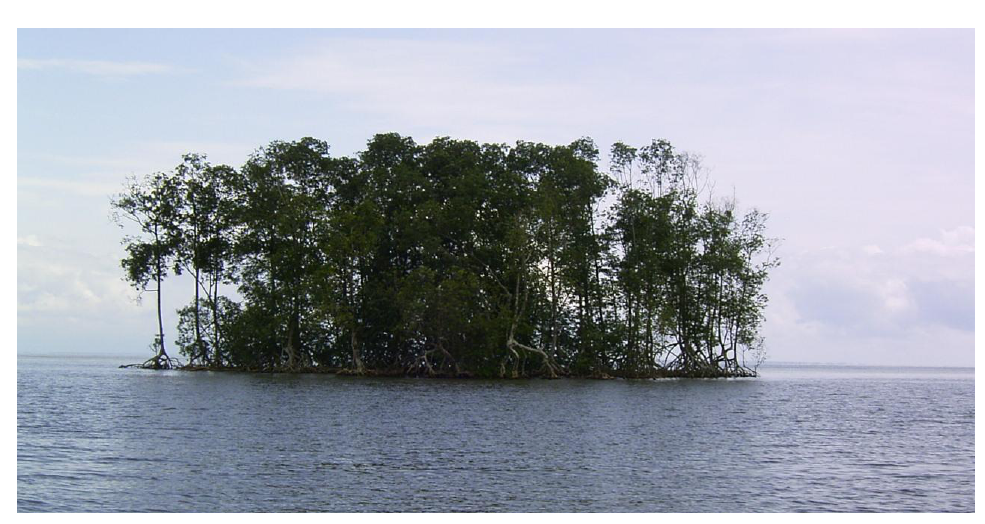
Figure 5. Kwelekwele Island in June 2009, showing evidence of forest retreat with open trees at the island edge and lack of canopy cover descending to near water level that is normal for seaward edge mangroves.